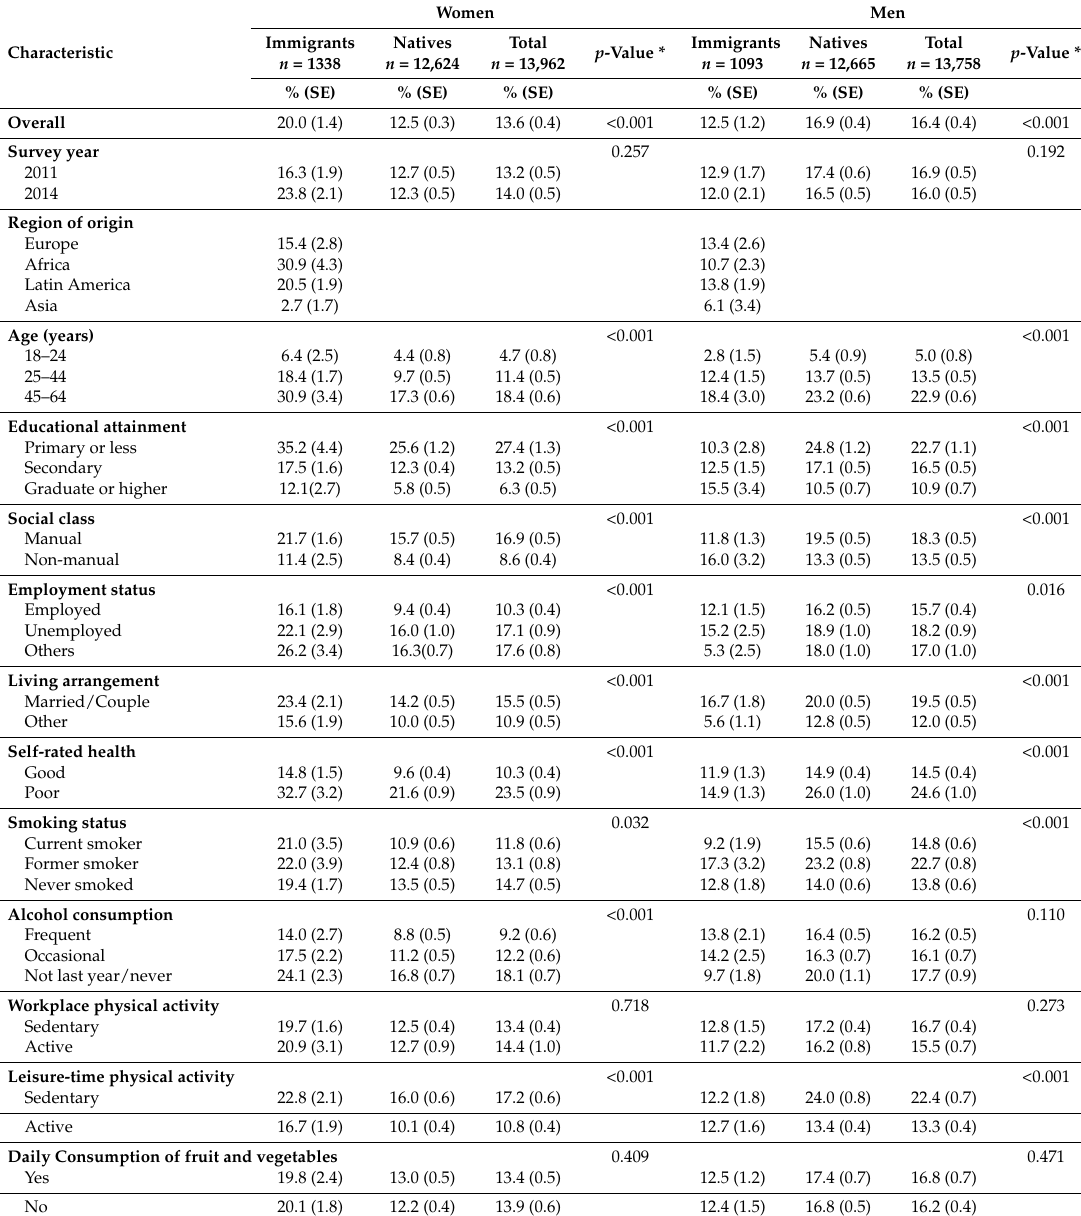
Table 2. Prevalence estimates for obesity according to place of birth in women and in men: Spanish National Health Survey 2011–2012 and European Health Survey in Spain